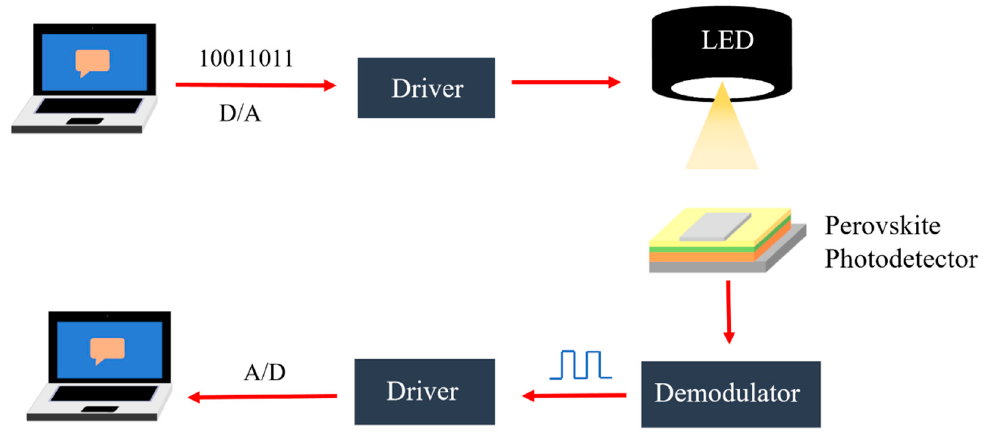
Figure 9. Schematic diagram of optical communication system.